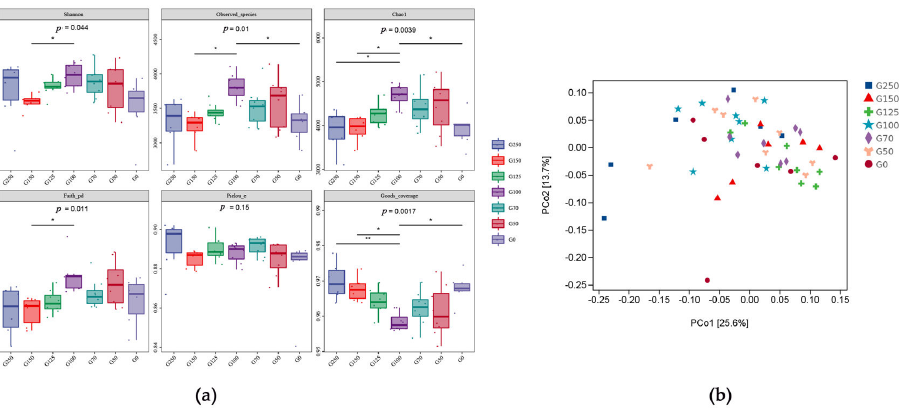
Figure 3. Diversity of soil bacteria between different forest gap sizes. ( a ) Alpha diversity of soil bacteria among different-sized forest gaps; ( b ) PCoA based on weighted UniFrac distance among different-sized forest